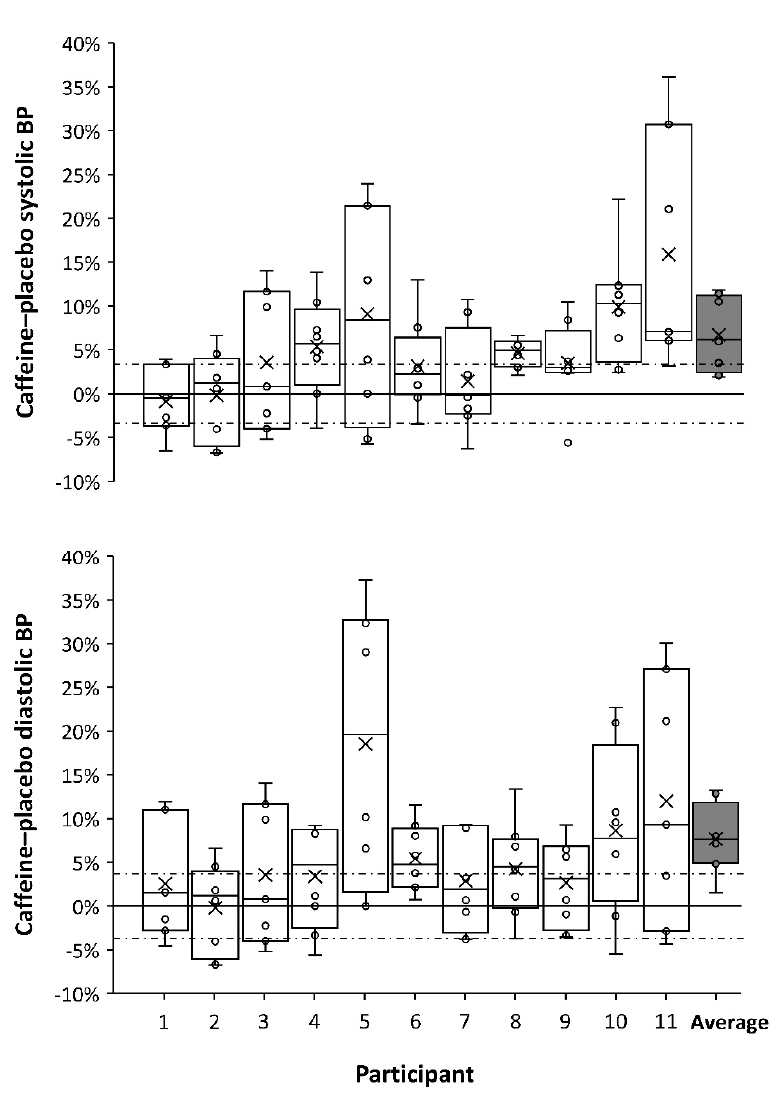
Figure 2. Box-and-whisker plots for the effects of 3 mg/kg of caffeine on resting systolic (upper panel) and diastolic (lower panel) blood pressure (BP). Caffeine was compared to a placebo on eight different occasions and each plot represents the results of these eight caffeine–placebo comparisons for each participant. “Average” represents the mean values for all 11 participants. The cross depicts the mean value for each individual while the lower, middle, and upper lines of the box represent the 25%, 50%, and 75% percentile for each individual. Whiskers represent the lowest and highest values (range). The black dashed line represents the natural variation of the systolic ( ± 3.3%) and diastolic blood pressure ( ± 3.8%) measured during the placebo